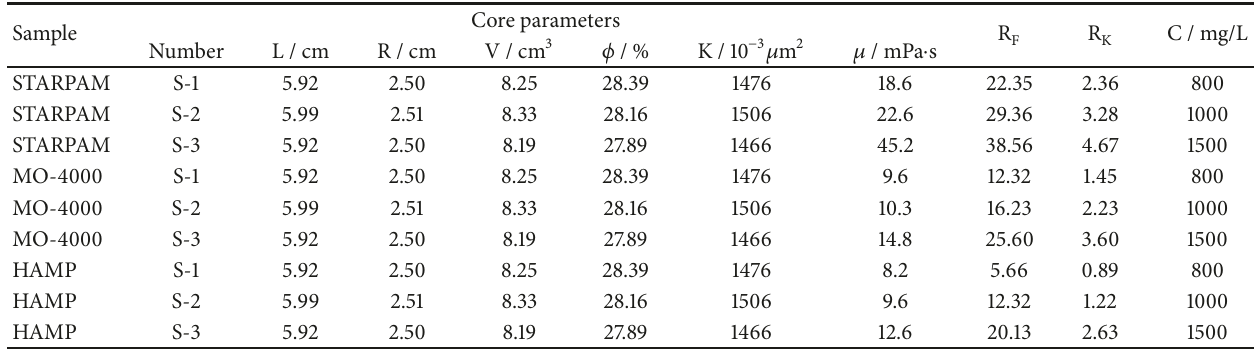
Table 8: Resistance coefficient and residual resistance coefficient of three polymers.